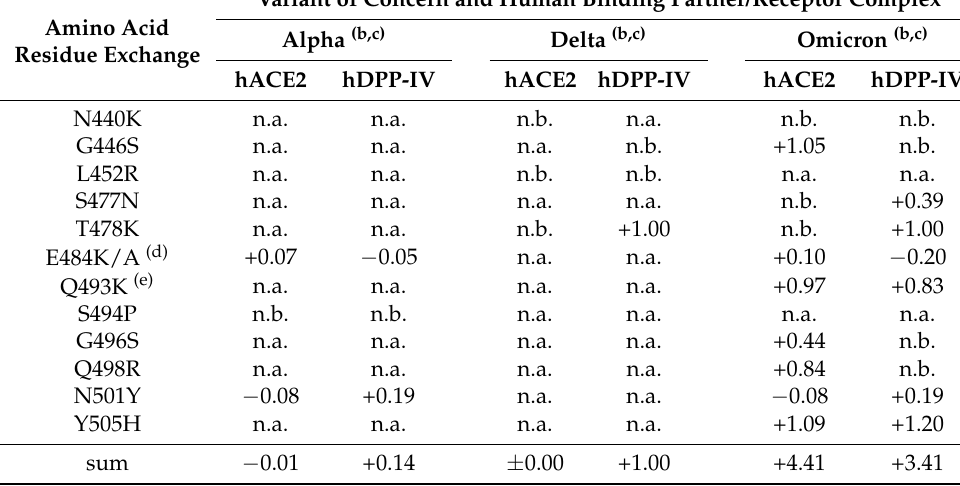
Table 2. Spike protein receptor binding motif amino acid exchanges and changes of free energies with human ACE2 binding or human DPP-IV binding (a) .